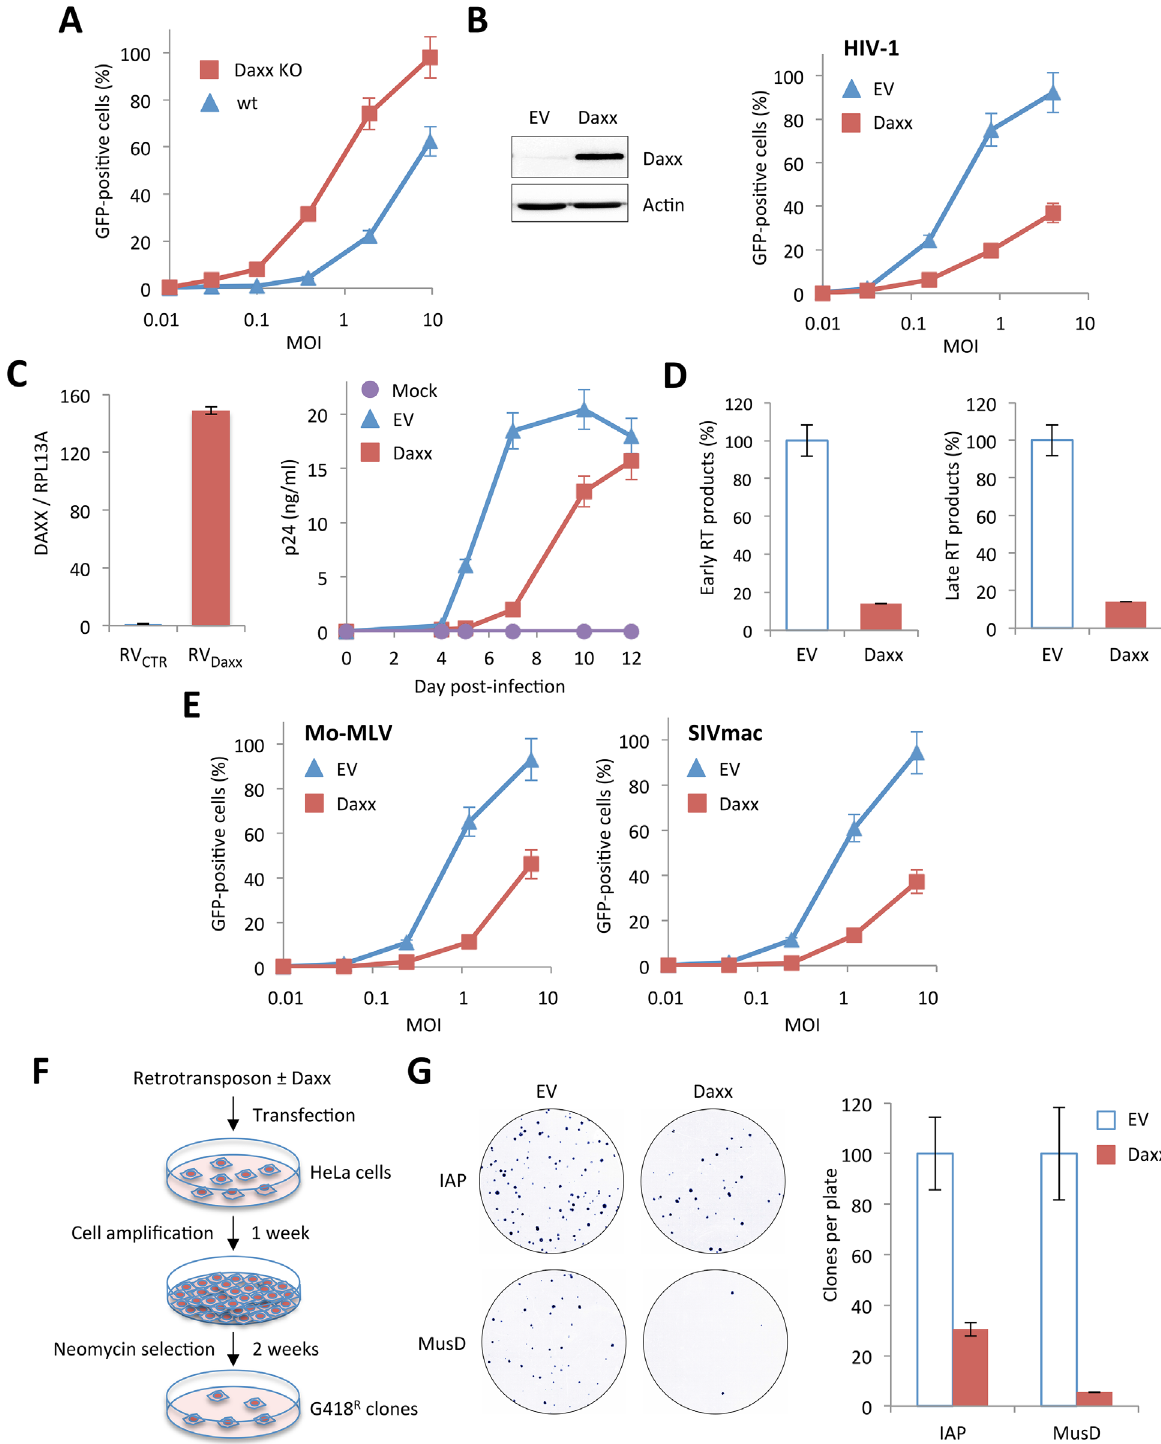
Fig 6. Inhibition of retroviral infections and retro-transposition by Daxx. (A) Wt and Daxx KO MEFs were transduced with increasing doses of HIV-1 vector and the percentage of GFP-expressing cells was determined 48 h later by flow cytometry. Means +/- SD of a typical experiment are shown. Similar results were obtained in three independent experiments. (B) Wt HeLa cells were transfected with an empty (EV) or a Daxx-encoding plasmid. Two days post- transfection, Daxx expression was evaluated by Western-blot analysis (left panel) and the percentage of GFP-expressing cells was determined by flow cytometry 48 h post-transduction with increasing doses of HIV-1 vector (right panel). Graph shows means of triplicate values +/- SD, representative of two